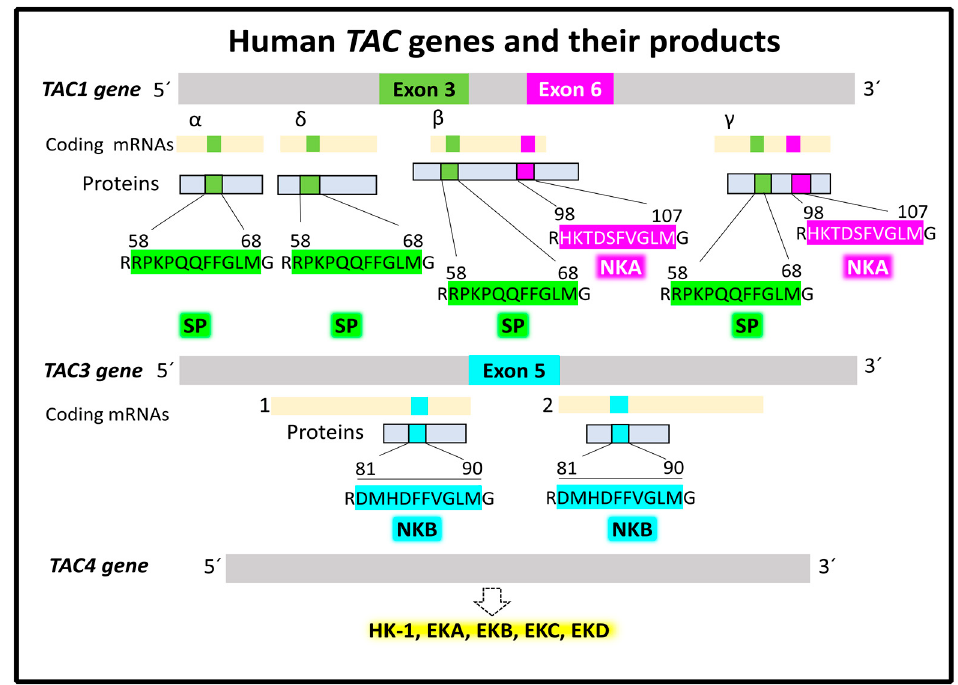
Figure 2. Human tachykinin genes and their main products, SP, NKA, and NKB. Alternative splicing generates several mRNA isoforms transcribed into protein products that undergo post-translational modifications (protein hydrolysis and amination of C-terminal methionine), giving rise to functional tachykinins. Data supporting this scheme are from the UNIPROT [25] and Entrez Gene (National Library of Medicine) [34] databases.